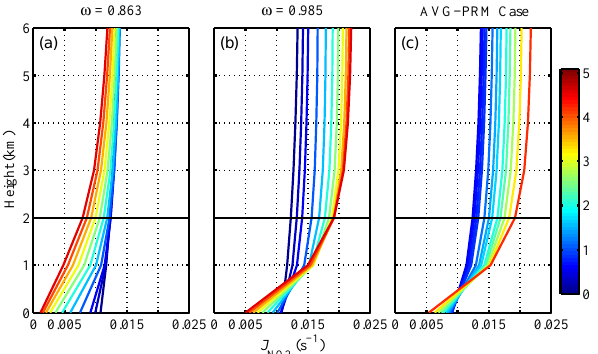
in three cases (a, b, c) , as in 2